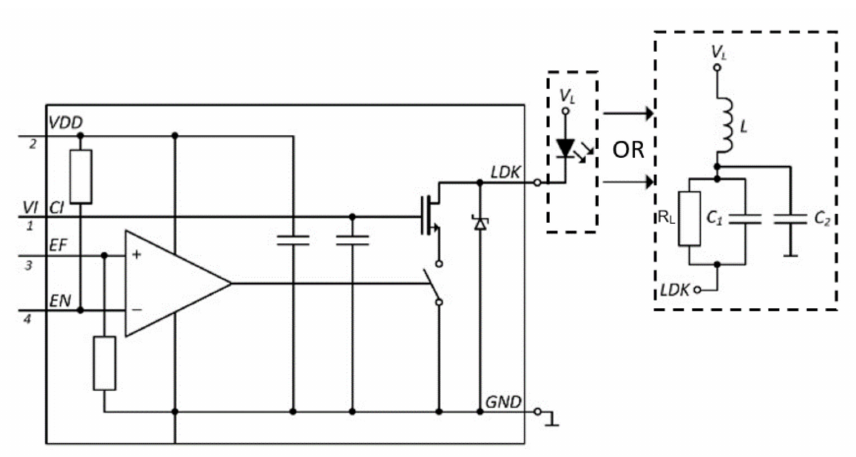
Figure 2. Electrical scheme of the IR modulator ( V DD —voltage supply of the module, VI ( CI )— voltage control of output current, EF - EN —differential triggering